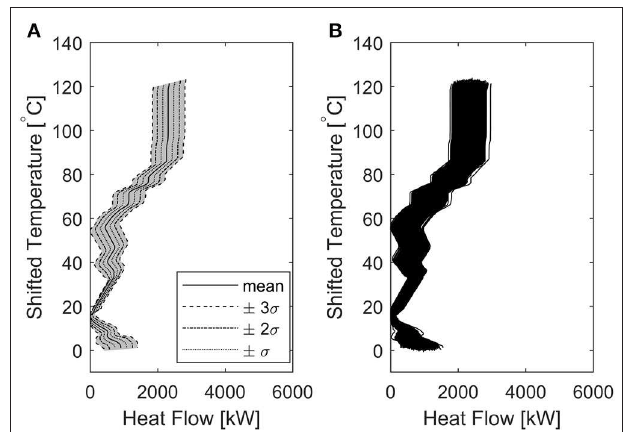
FIGURE 13 | Grand Composite Curve considering minimum uncertainties for the k = 205 parameters. (A) probability area for the GCC, (B) aggregated GCC resulting from the N = 5,000